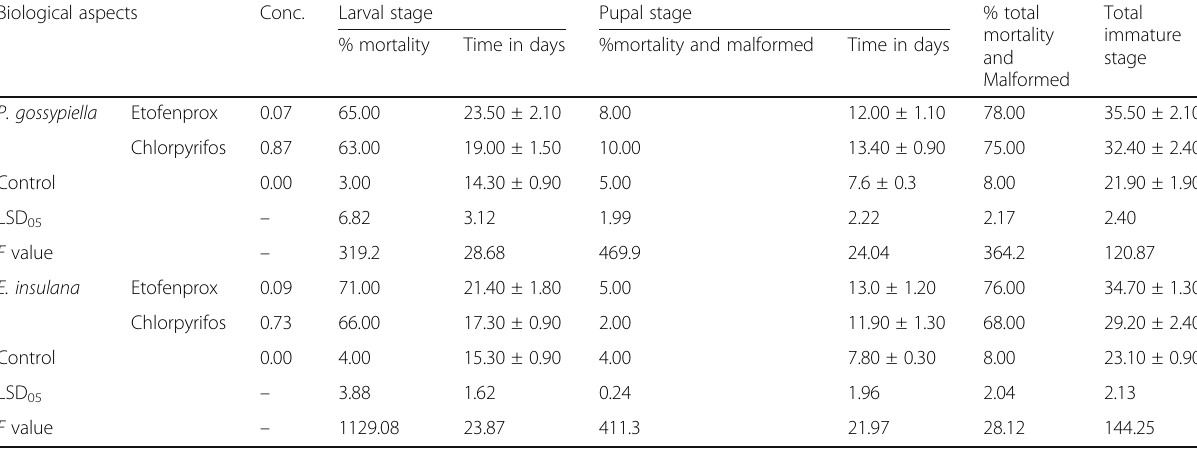
Table 2 Effect of tested compounds on different stages of P. gossypiella and E. insulana treated as newly hatched larvae Biological aspects